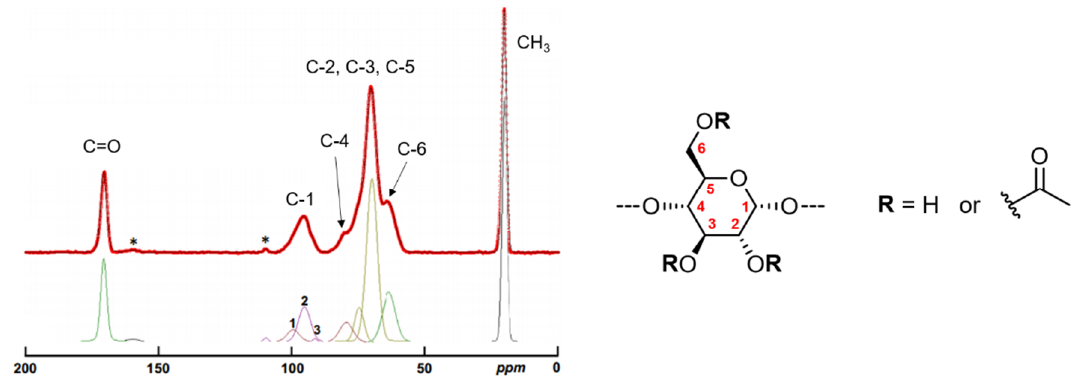
Figure 3. Solid-state 13 C-NMR spectrum obtained for acetylated waxy maize starch (DS 2.6) and its spectral decomposition. * Spinning side band.